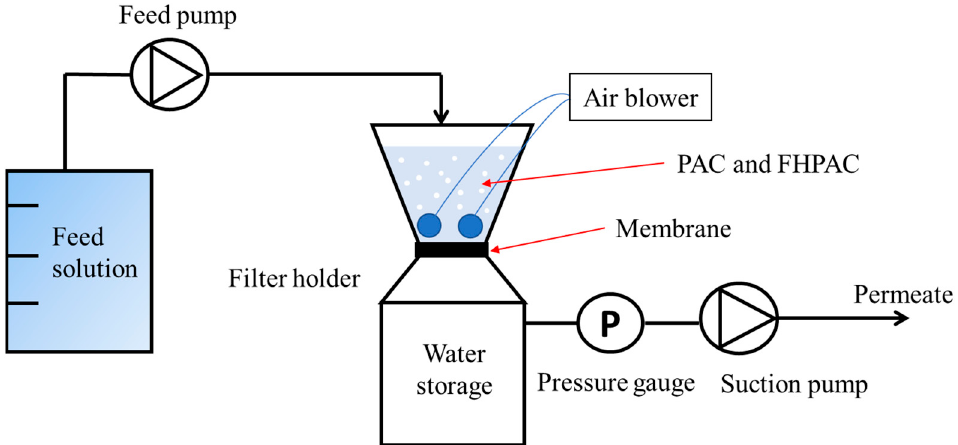
Figure 1. Schematic diagram of the hybrid adsorption and membrane system.